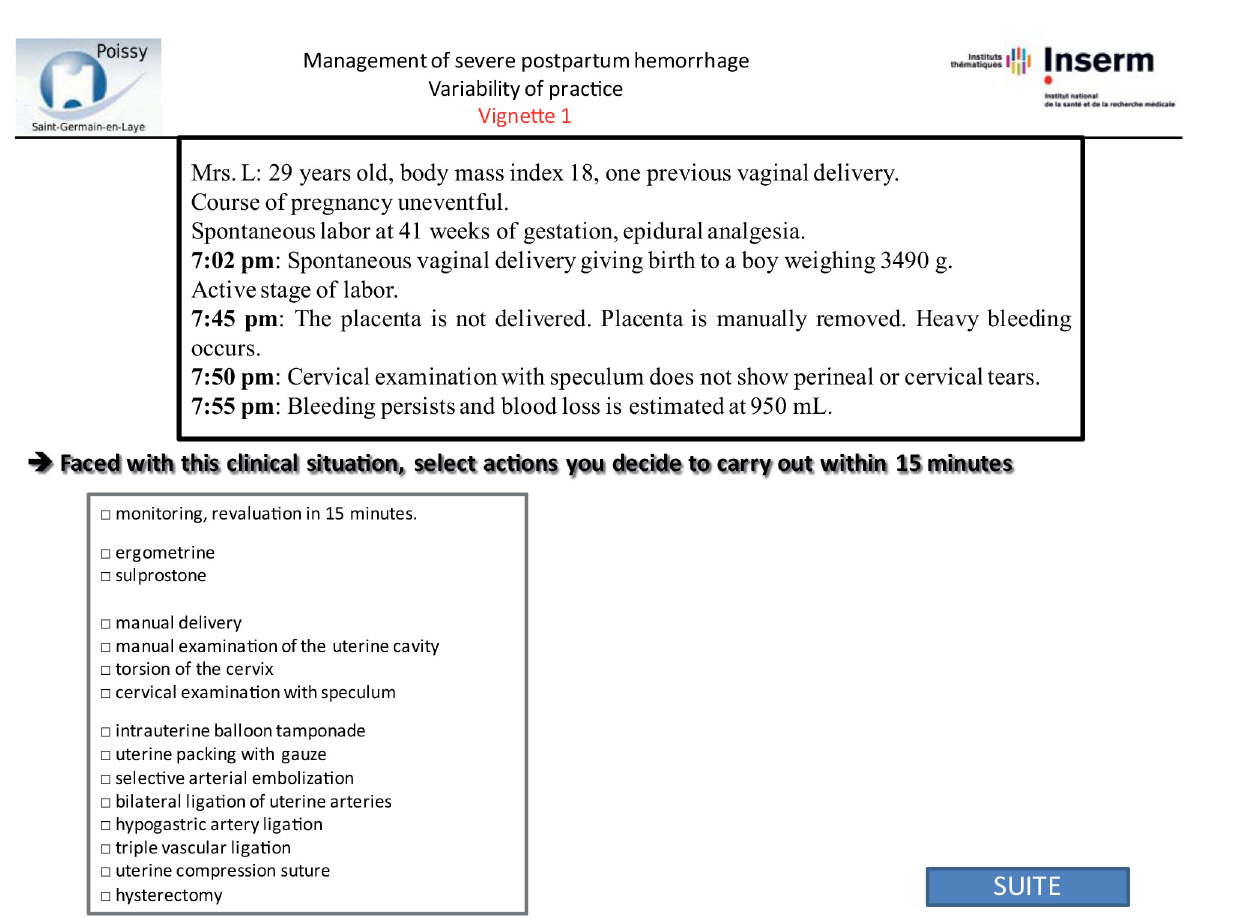
Fig 1. Step 1 of sample vignette. This figure corresponds to screenshot of the website: first step of vignette with closed-ended question.